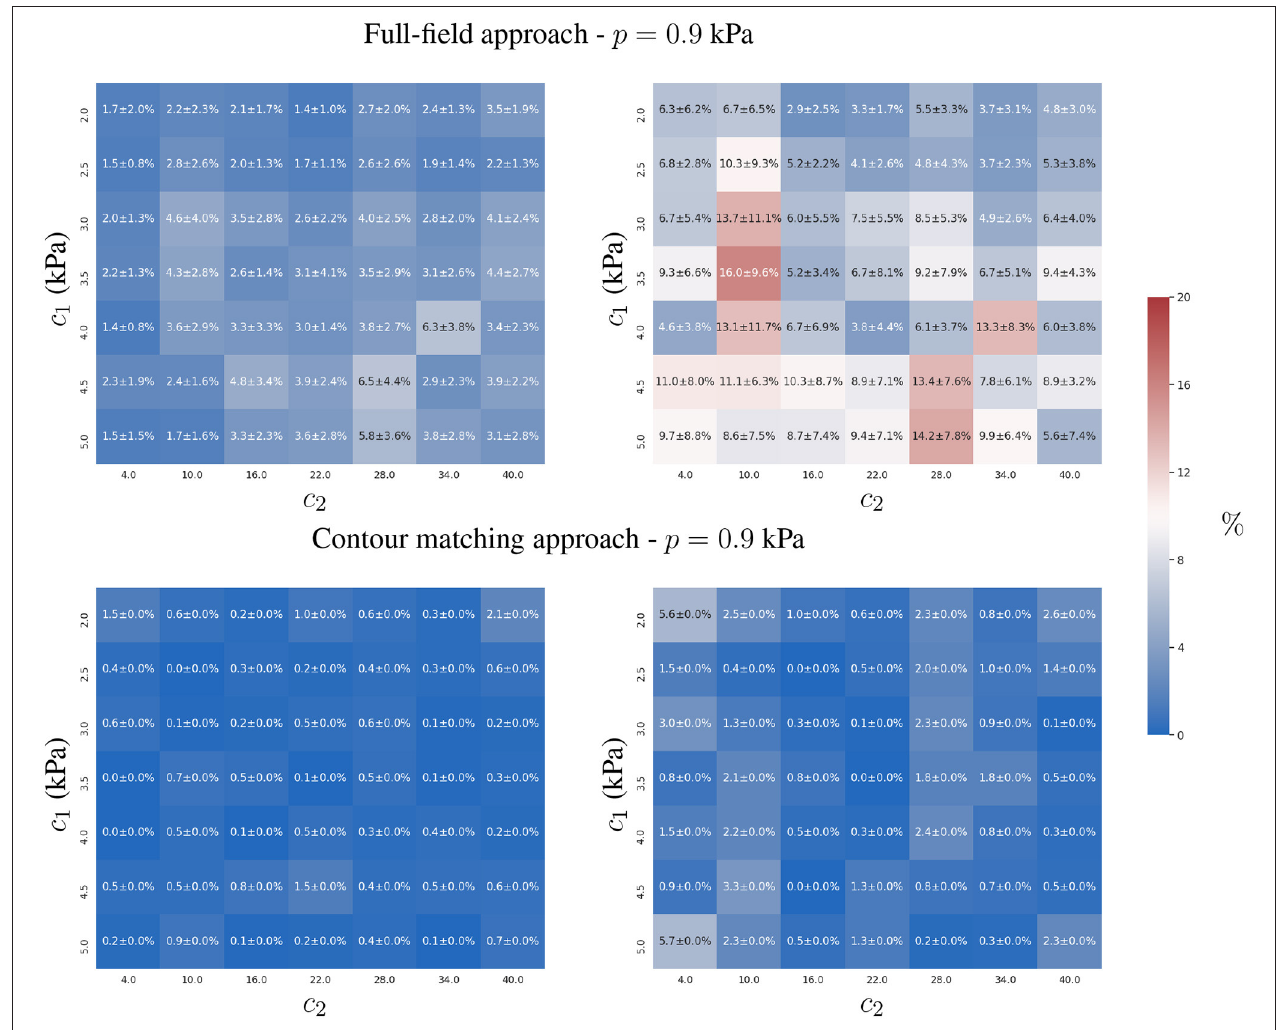
FIGURE 4 | Mean and standard deviation of the relative error for the two-parameter estimation of c 1 (left) and c 2 (right) constitutive parameters using the full-field tracking and contour matching approaches with a load of p = 0.9 kPa and the presence of Gaussian noise ( σ = 1mm ≈ 2 pixels) in the observations. For details of estimations for other loads, refer to the Supplementary Material